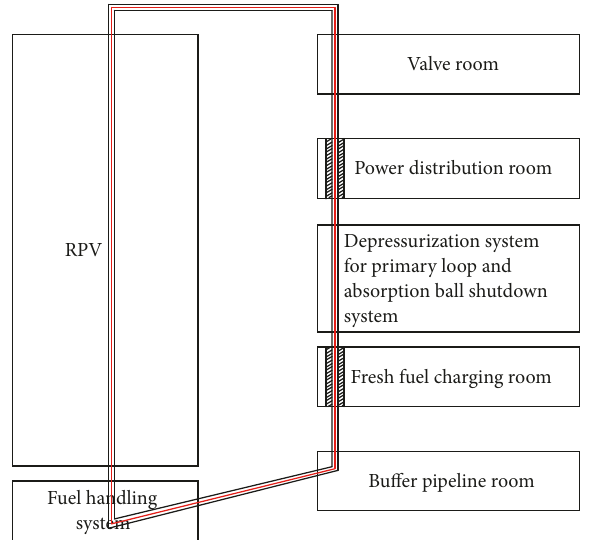
Figure 4: Simplified sketch of the fuel transportation path and the related room layout. The red line indicates the primary fuel transportation path and the shaded block indicates the concrete shielding